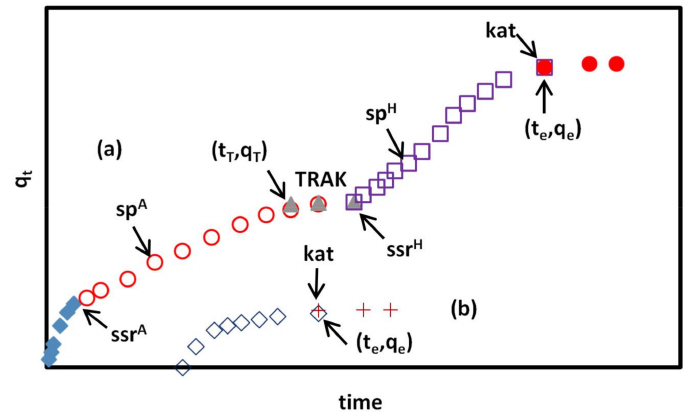
Figure 6. (a) Typical bi-curve adsorption kinetic diagram of CR adsorption on GO/PAMAM in water and 0.1 M NaCl solutions according to the KASRA model. The first bi-regional kinetic curve ends at ( t ) point and the second single-region kinetic curve starts from ssr H point. The superscripts of T , q T A , H , and NH refer to –NH 3 + , hydroxyl, and –NH 2 sites, respectively. In alkaline solutions (except at pH = 13), the superscript H is replaced by NH ; (b) At pH of 13, the diagram composes of a single-region curve, including only –NH 2 sites. sp A , sp H and sp NH 2 symbols refer to sp points in the ISO equation. TRAK is an abbreviation for the “ time range of interval between two successive adsorption kinetic curves